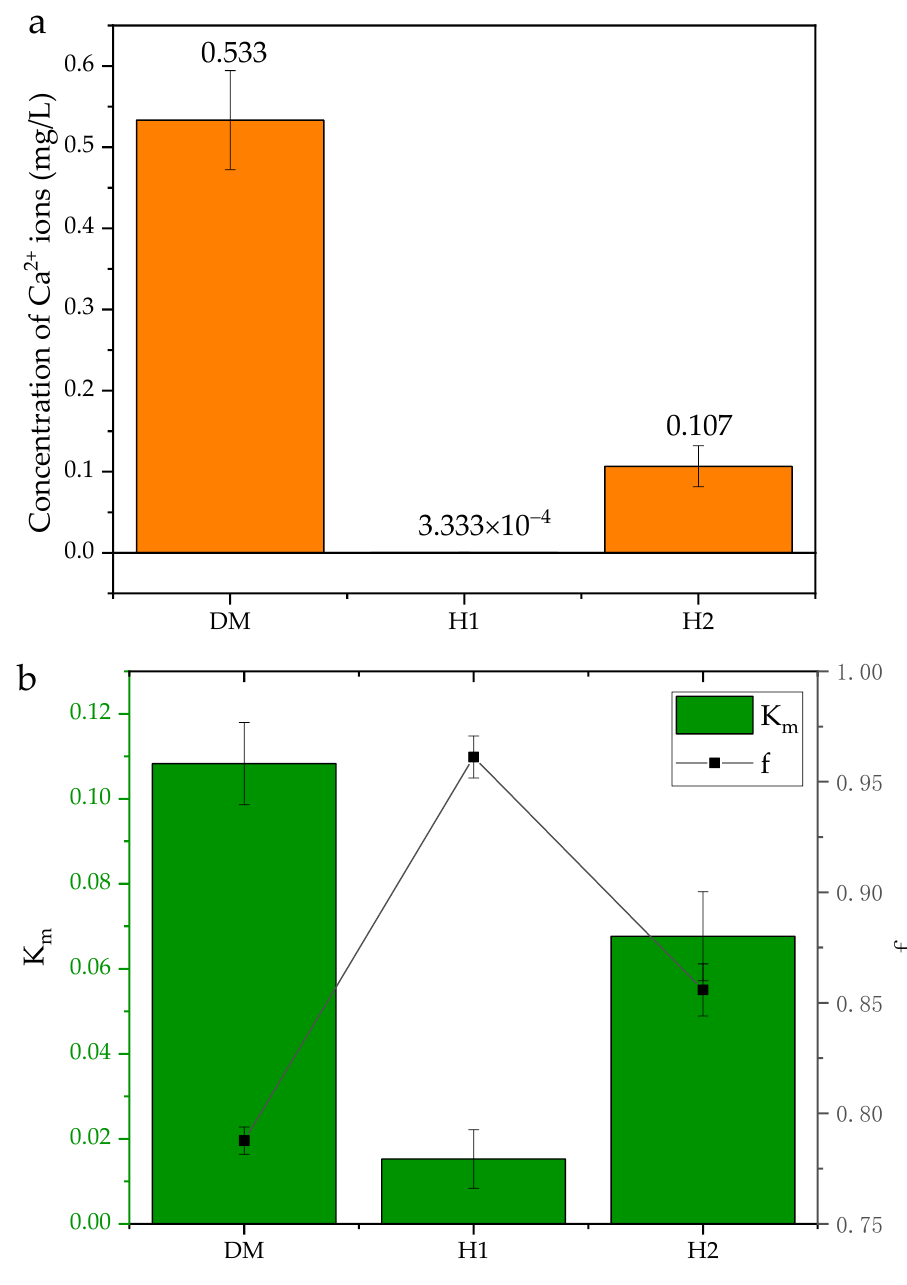
Figure 7. Reliability and durability of the coating: ( a ) The acid resistance of samples; ( b ) Freeze–thaw test results.